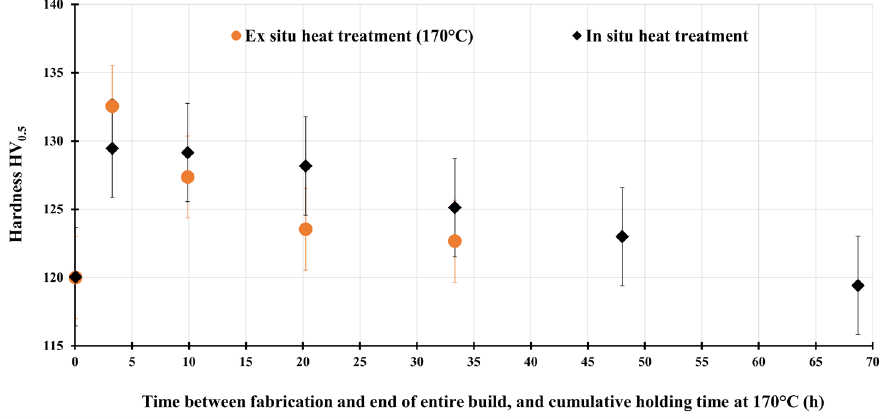
Figure 11. Hardness evolution of ex situ heat treatment at 170 °C of top sample and hardness profile of fabricated samples with respect to building height (sample from area 3).